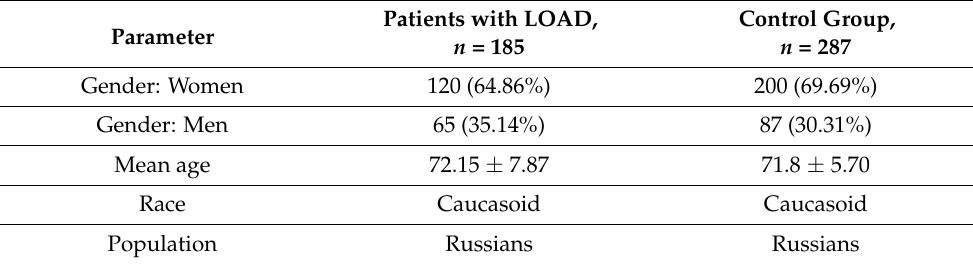
Table 1. Demographic parameters of the studied groups.